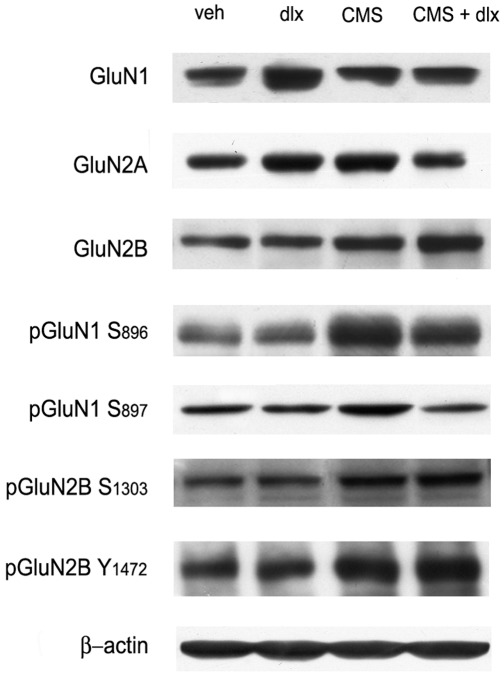
Representative Western blotting of NMDA receptor subunits in ventral hippocampus.Representative western blot analysis of of GluN1, GluN2A, GluN2B, phospho GluN1 (Ser896), phospho GluN1 (ser897), phospho GluN2B (Ser1303), phospho GluN2B (Tyr1472) expression in crude synaptosomal fraction from adult brain ventral hippocampus. β-actin is shown as control for comparison. Veh vehicle, dlx duloxetine, CMS chronic mild stress, CMS + dlx chronic mild stress + duloxetine. Experimental conditions are described in Material and Methods.